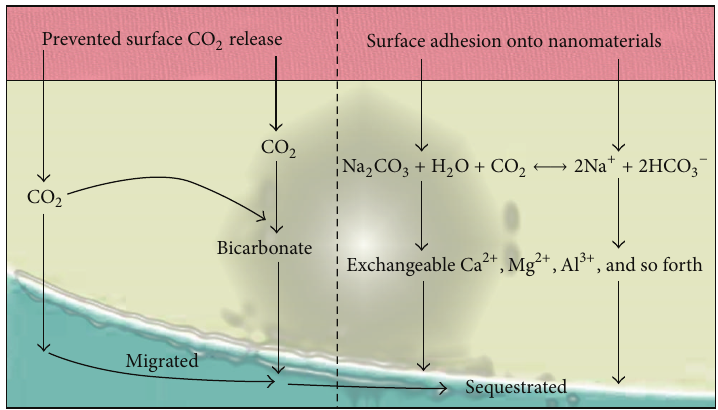
Figure 8: Hypothetical CO 2 footprints beneath nanodeserts and the C sink kinetics in CO 2